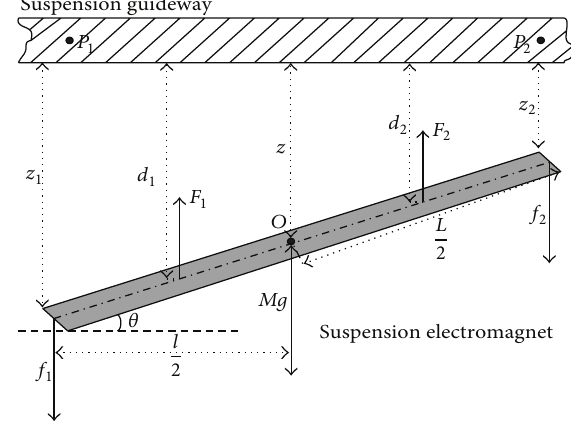
Figure 2: Suspension system’s force analysis